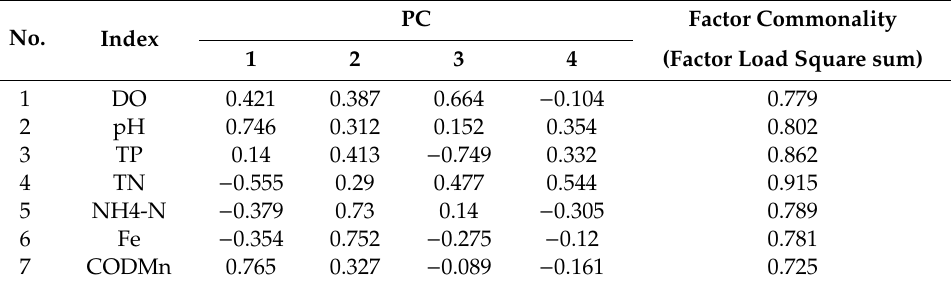
Table 3. Water quality index load.